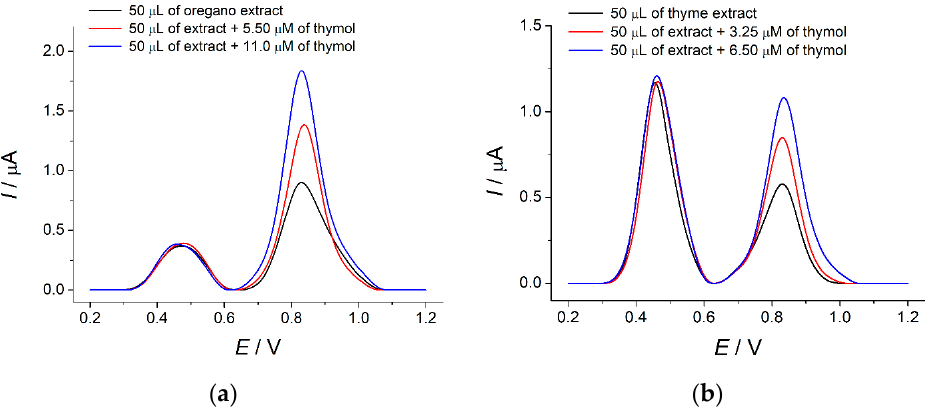
( a ) ( b ) Figure 12. Baseline-corrected DPVs of spices extracts at the polythymolphthalein/MWCNTs/GCE in the Britton–Robinson buffer pH 2.0: ( a ) oregano extract with standard additions of thymol; ( b ) thyme extract with standard additions of thymol. Δ E mod = 100 mV, t mod = 25 ms, υ = 20 mV s − 1 . Table 5. Quantification of the total content of isopropylmethylphenols in spices ( p = 0.95).